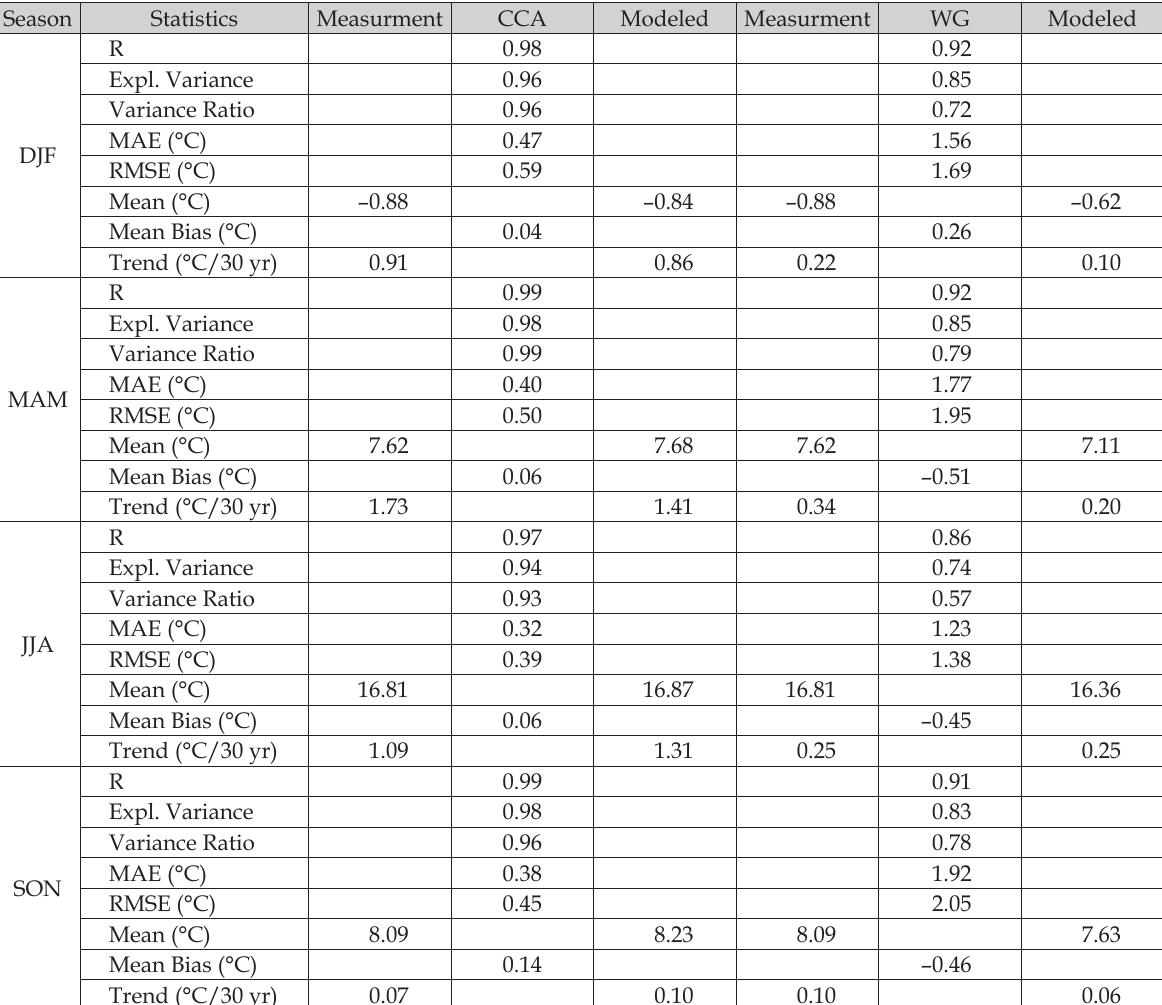
Table 1. Verification statistics of WG and CCA models developed for the mean air temperature of Poland (aver- age of all stations) in several seasons (DJF, MAM, JJA, SON) in the calibration period 1971–2000.